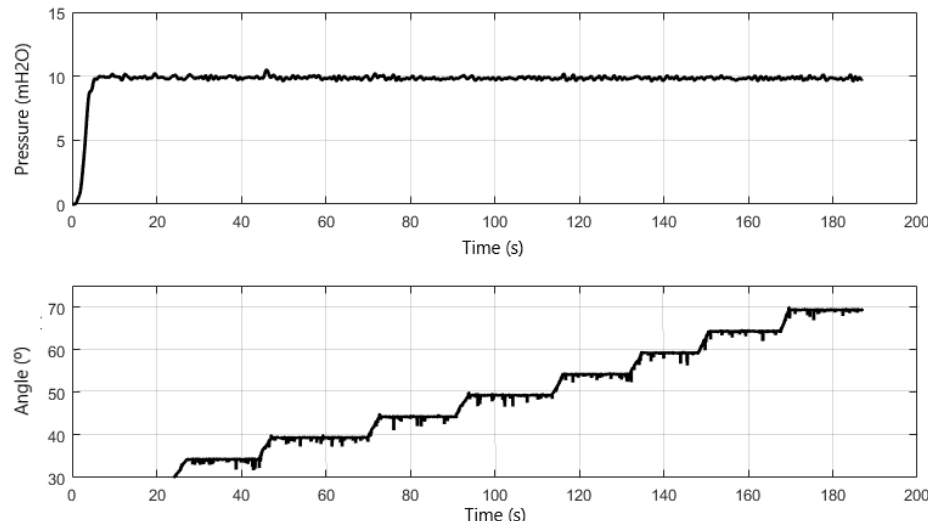
Figure 8. Response of the controlled system under varying water demand for a single pump (MB 1).